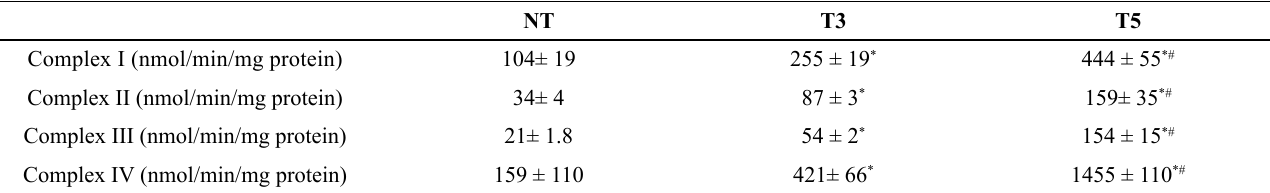
Table 1: Mitochondrial respiratory chain enzyme activities in the quadriceps muscle from healthy mice trained in a treadmill for three-time (T3) or five-time (T5) per